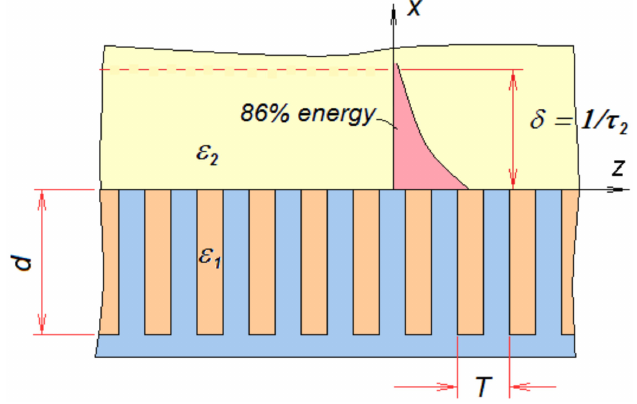
Figure 1. Geometry of a metal comb-like slow-wave structure.